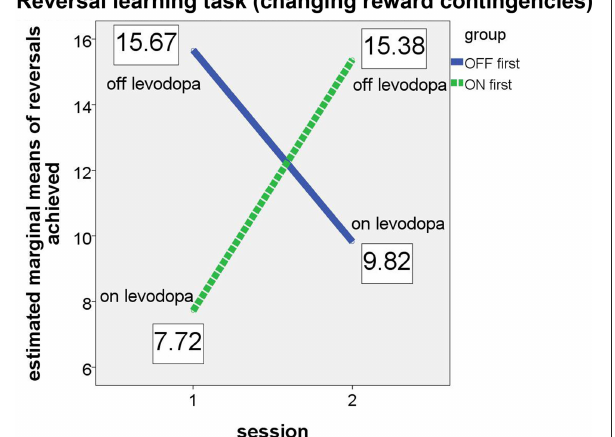
FiGure 2 | Performance of ON-beginner (“ON first”) and OFF-beginner (“OFF first”) subgroups across sessions on the reversal learning task. Covariate-corrected estimated means of the number of reversals achieved are shown in